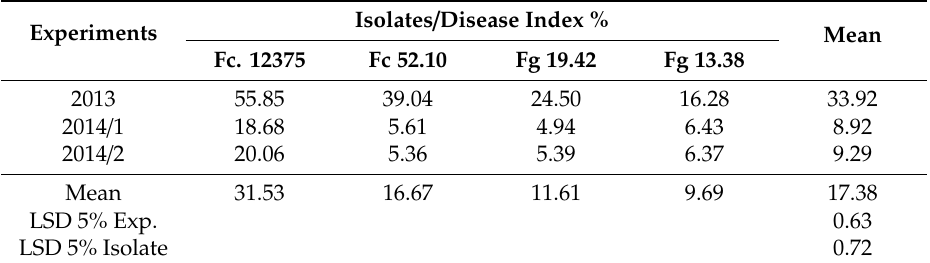
Table 3. Mean aggressiveness of the F. graminearum and F. culmorum isolates of the dilution tests in the three tests, 2013–2014, Disease index data % across dilutions and genotypes (No. replicates = 126).